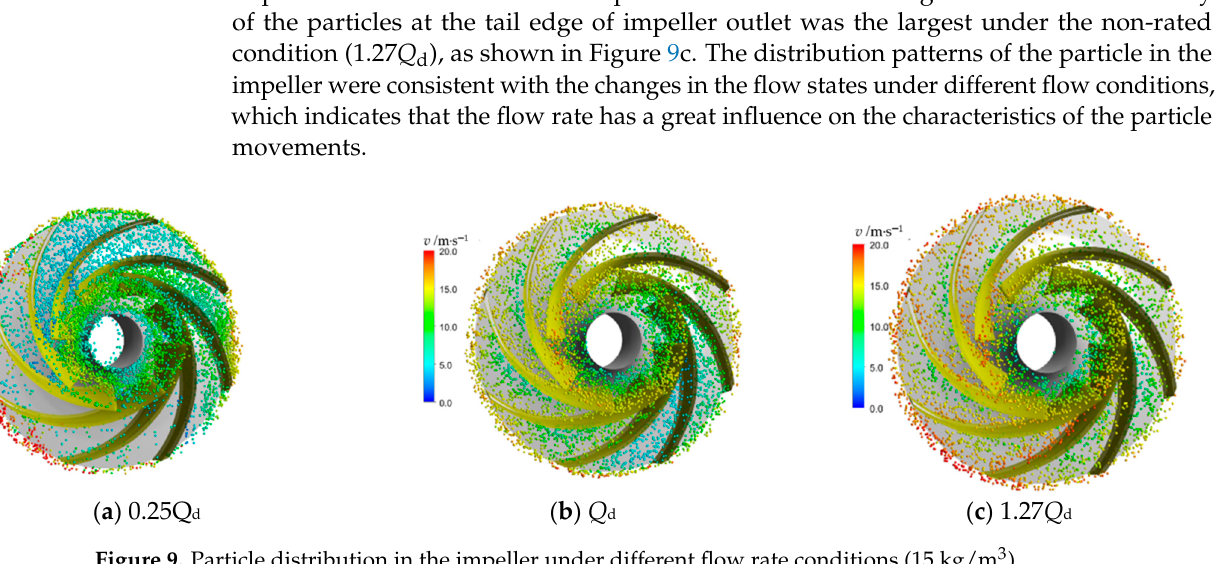
Figure 9. Particle distribution in the impeller under different flow rate conditions (15 kg/m 3 ).